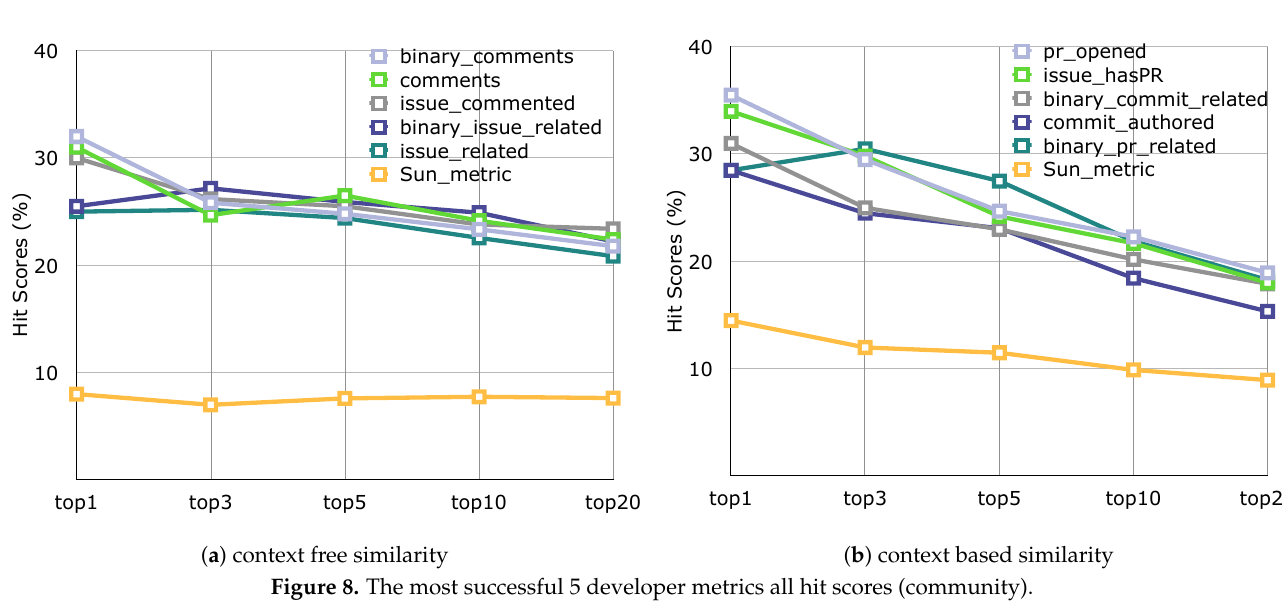
Figure 8. The most successful 5 developer metrics all hit scores